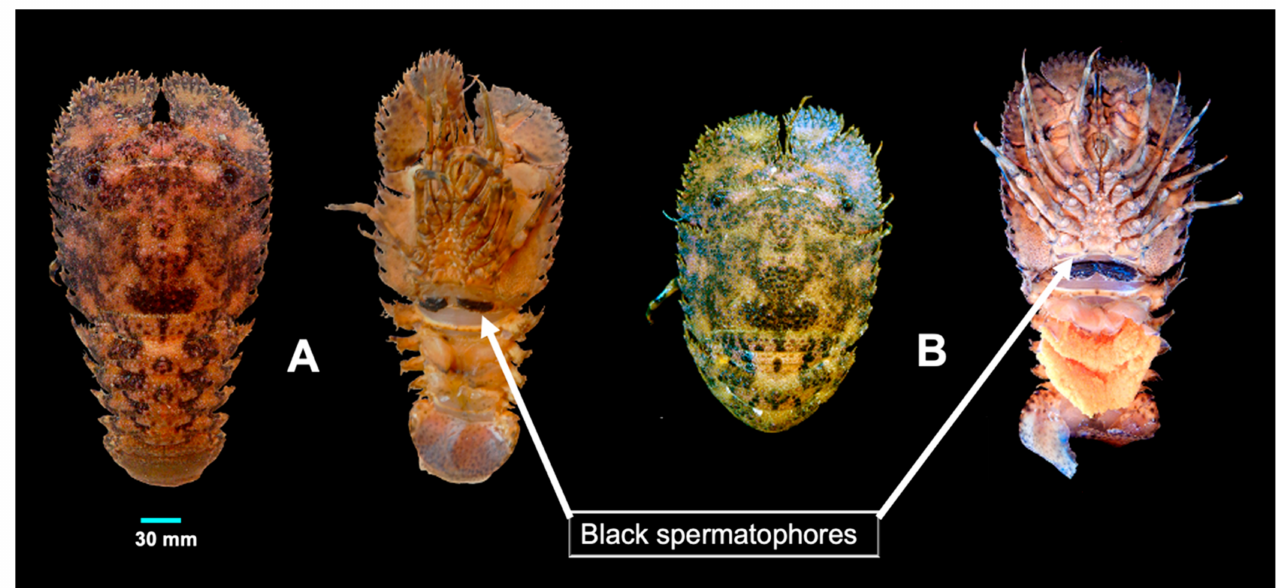
Figure 7. Dorsal and ventral view of two female Parribacus antarcticus (Lund, 1793). ( A ) Black spermatophores and pleopods with long setae. ( B ) Eggs concomitant with fresh spermatophores. Adapted from Cintra, et al.